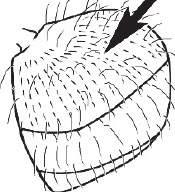
38 Mesonotum and propodeum globose, mesonotum, mesopleuron and propodeum separated from each other by a deep sulcus (WA, NT) ( JDM